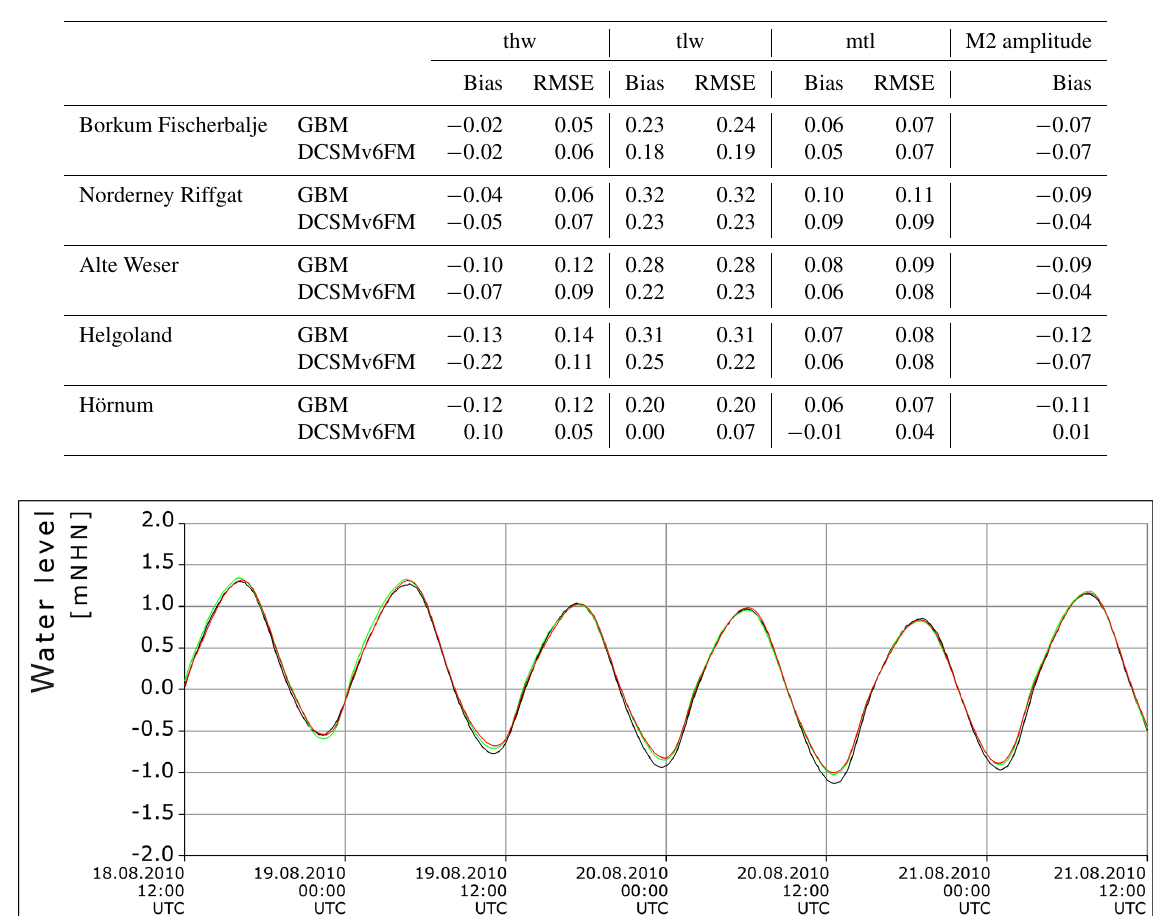
Table 1. Bias and root-mean-square error for four tidal parameters (tidal high water, tidal low water, mean tide level and M2 amplitude) given in metres at different stations in the German Bight for the German Bight Model and the DCSMv6FM (stations marked in Fig. 2).